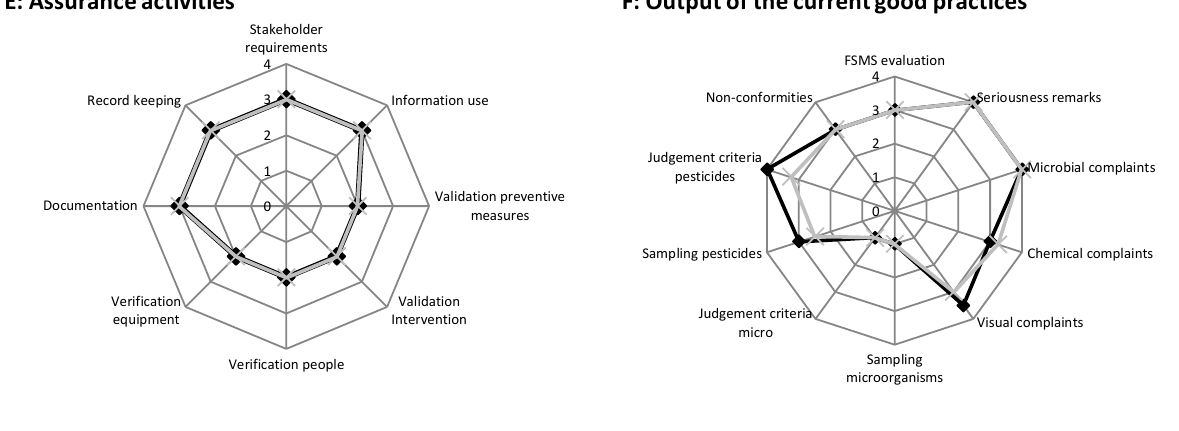
Figure 1. Spiderwebs demonstrating the mean of the results of the self-assessment tool on current agricultural practices and management systems of the eight farms, greenhouse farms ■ and open field farms × A , B : Level 1 low-risk, level 2 medium-risk, and level 3 high-risk situations. C , D , E : Level 1 activity is not present; level 2 activity is conducted based on historical knowledge of the farmers based on self-insights; level 3 activity is performed based on best practices according to guidelines; and level 4 activity is tailored and fit-for-purpose for the farm-specific situation. F : Level 1, no information is available; level 2, ad hoc information is present and sometimes problems occur (reactive behavior of farmers); level 3, systematic information is collected and sometimes problems occur (proactive behavior of farmer); level 4, systematic information is present and no problems are